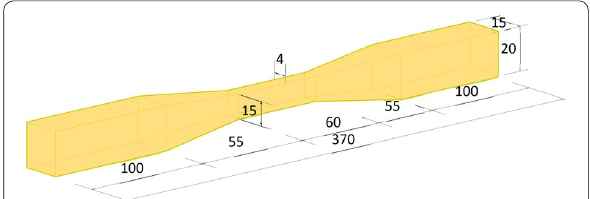
Fig. 1 Tensile testing sample with rift grain (unit: